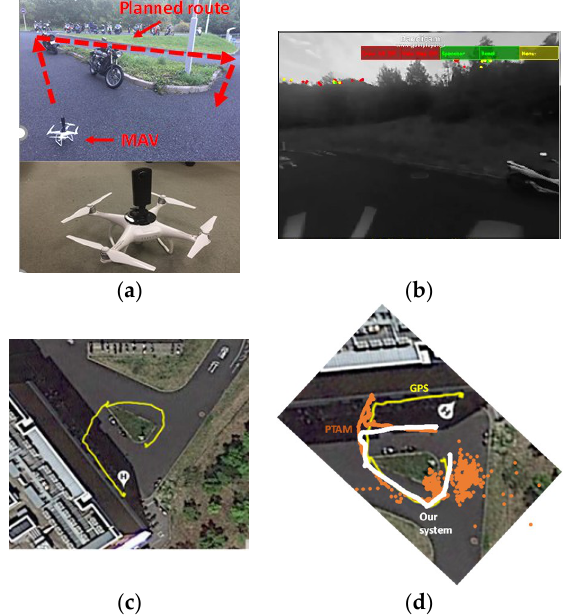
Figure 14. ( a ) full-view camera on the MAV; ( b )PTAM performs badly as MAV rotates or in a sparse feature view; ( c ) GPS flight trajectory; ( d ) The flight trajectory by GPS, PTAM, and our system.